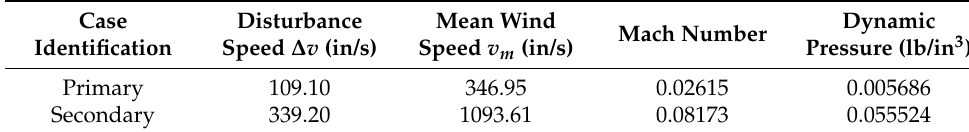
Table 1. Operational case summary [62].